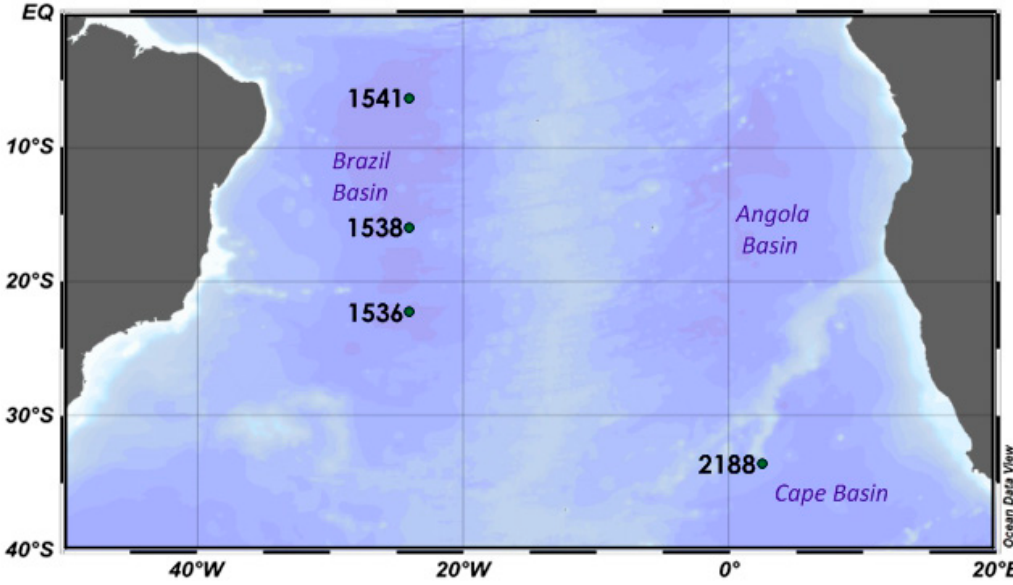
Figure 1. Location of crust and nodule samples.